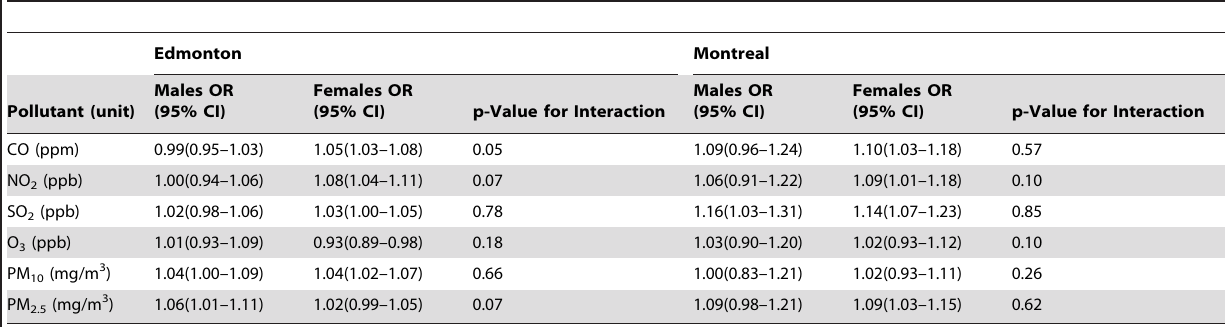
Table 2. Odds ratio for presenting to an emergency department with non-specific abdominal pain associated with an interquartile increase in an air pollutant concentration on the same day of ED visit stratified by gender among individuals aged 15–24 years.